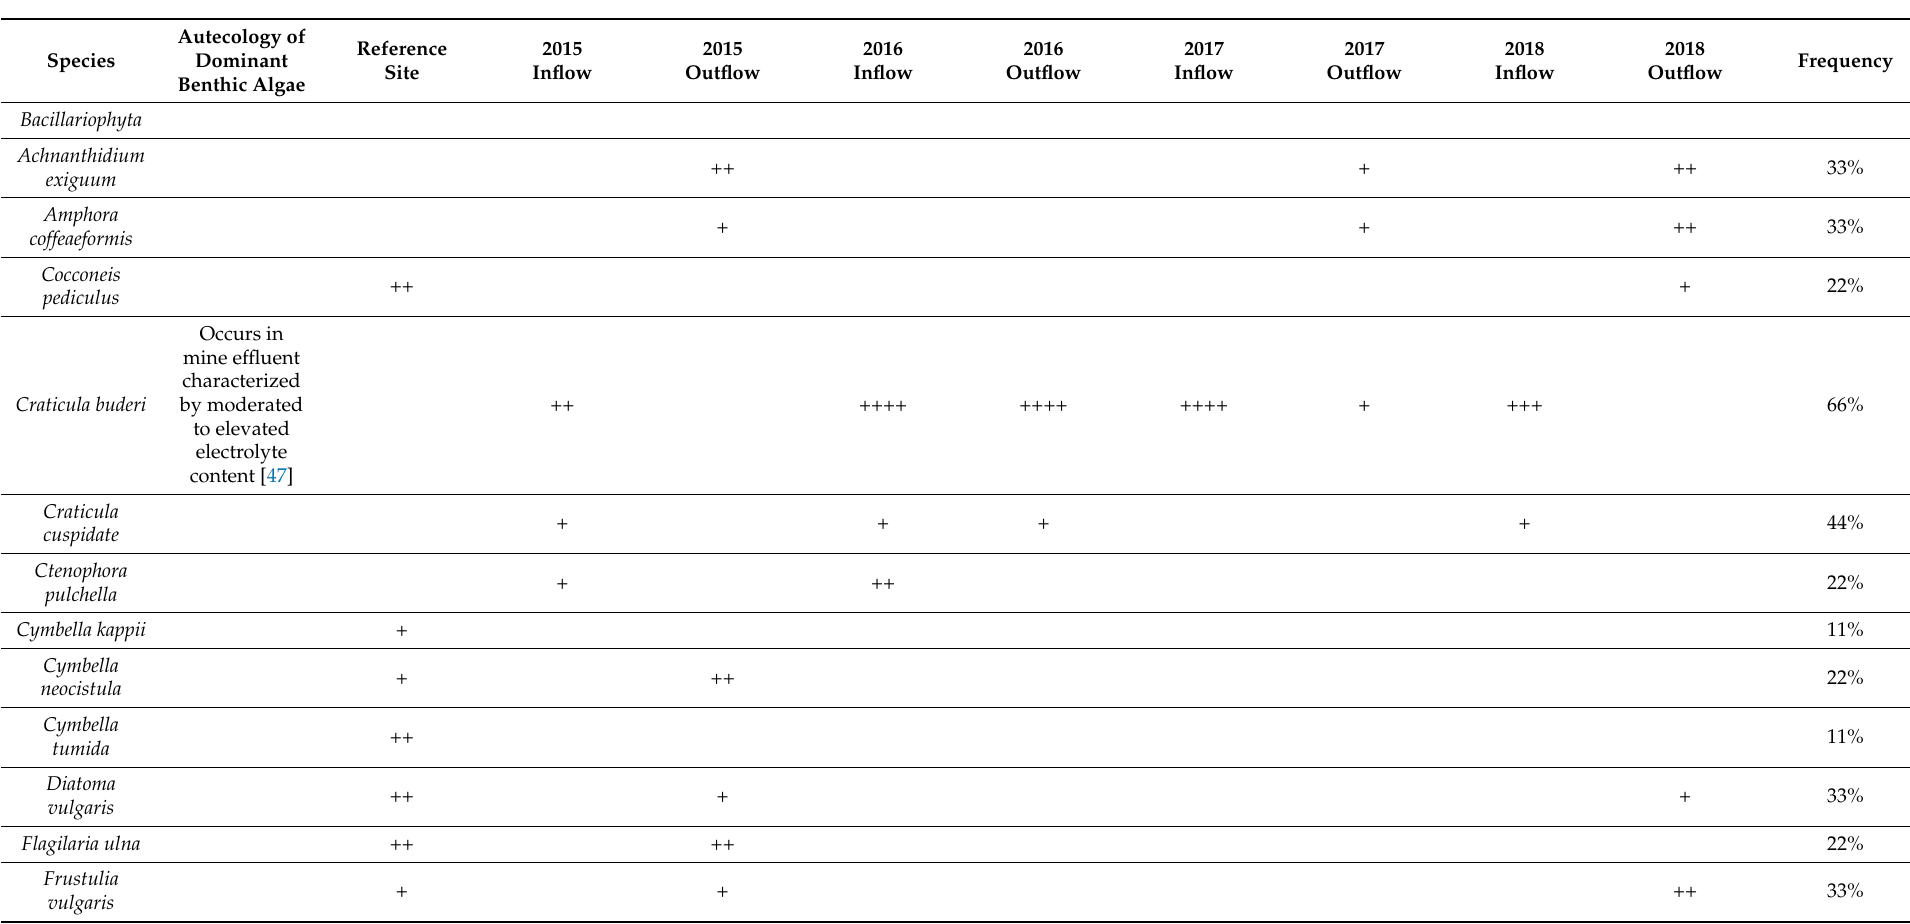
Table 2. Composition of the periphyton communities at the wetland area inflow and outflow over the period 2015–2018 ( n = 16)